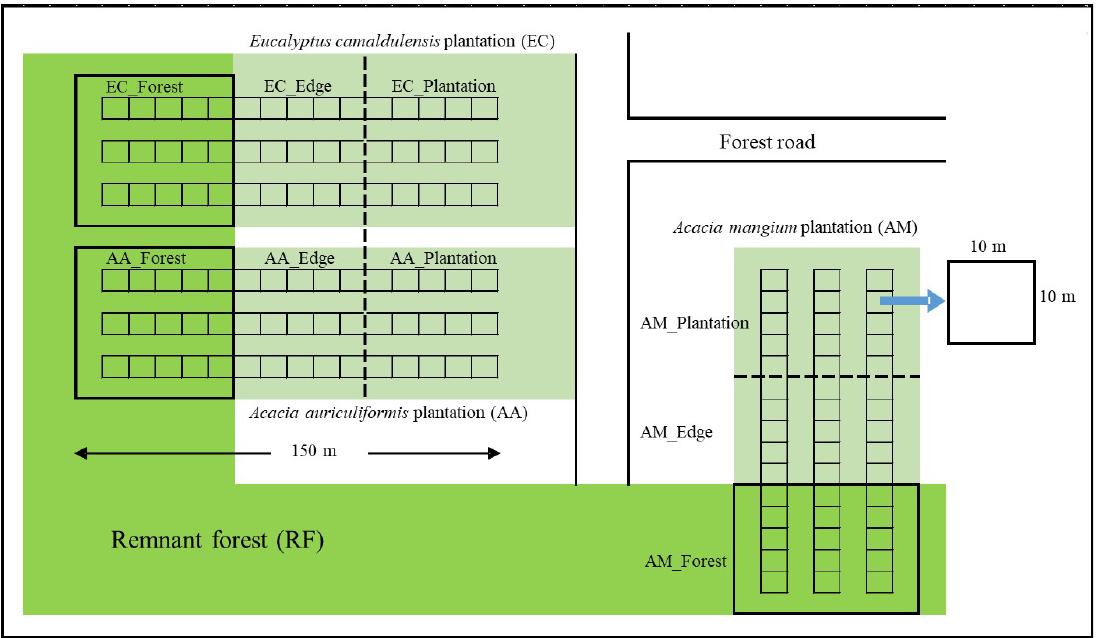
Figure 2. The layout of three transect lines of 10 m × 150 m set up along the forest remnant (Forest, − 50 m to 0 m) through forest–plantation edge (Edge, 0 m to 50 m) and plantation stand (Plantation, 50 m to 100 m) in three exotic plantations: Eucalyptus camaldulensis (EC), Acacia auriculiformis (AA), and A. mangium (AM).